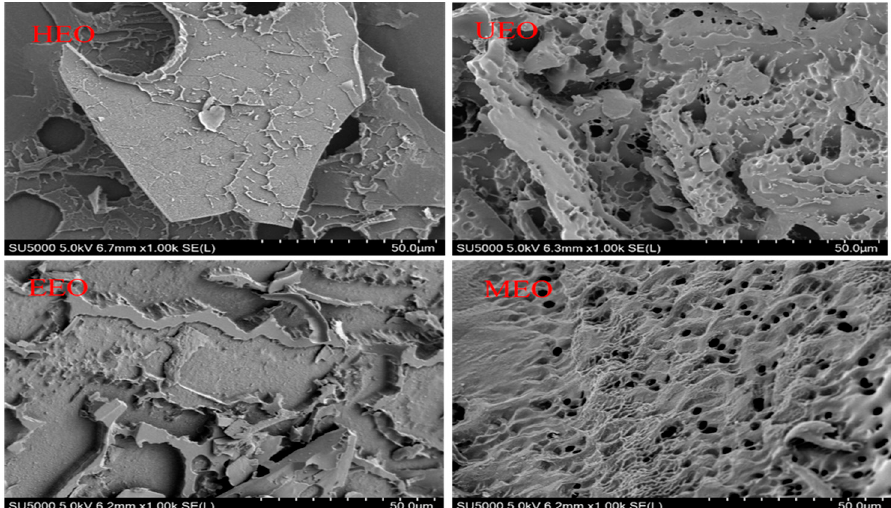
Figure 6. SEM (scanning electron microscopy) image analysis of EOs.